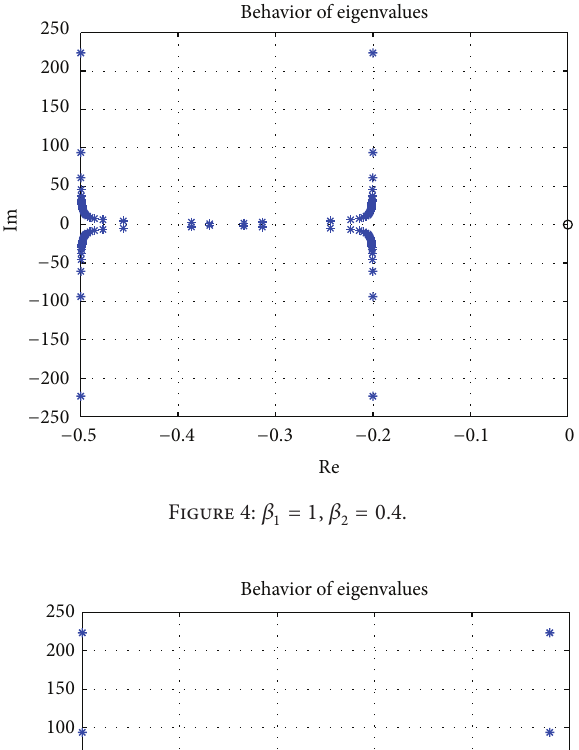
Figure 6: 𝛽 1 = 1 , 𝛽 2 = 0 .